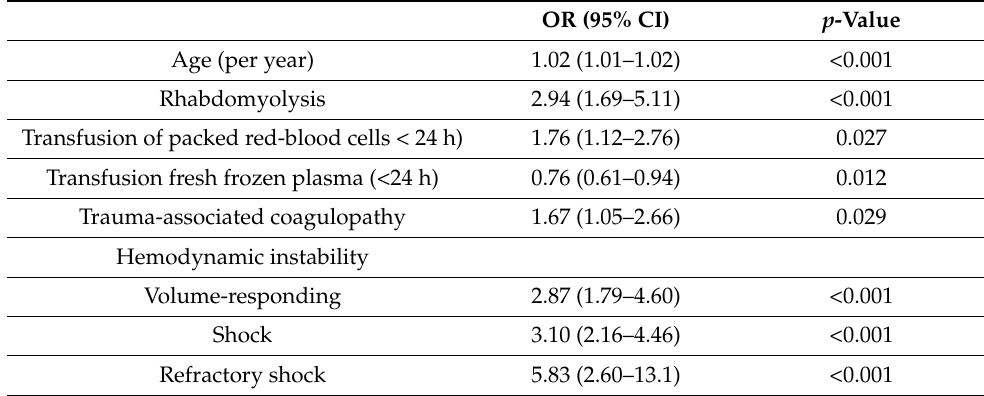
Figure 2. Risk of developing AKI according to age and the hemodynamic response. Table 3. The results of the logistic regression analysis aiming to identify risk factors associated with AKI.